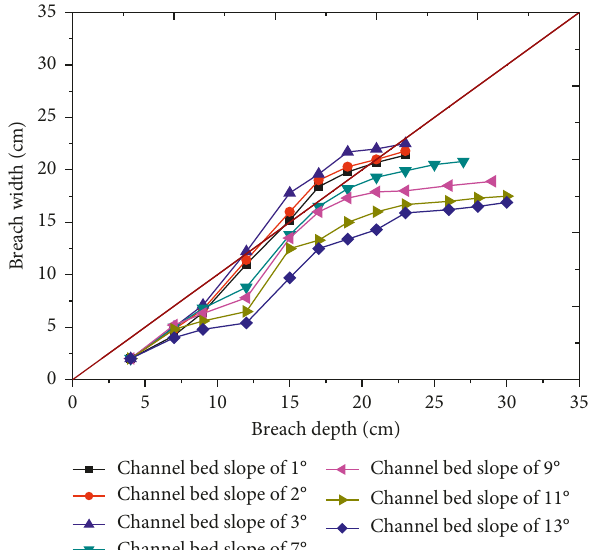
Figure 9: The relationship between breach width and depth for different bed slopes.